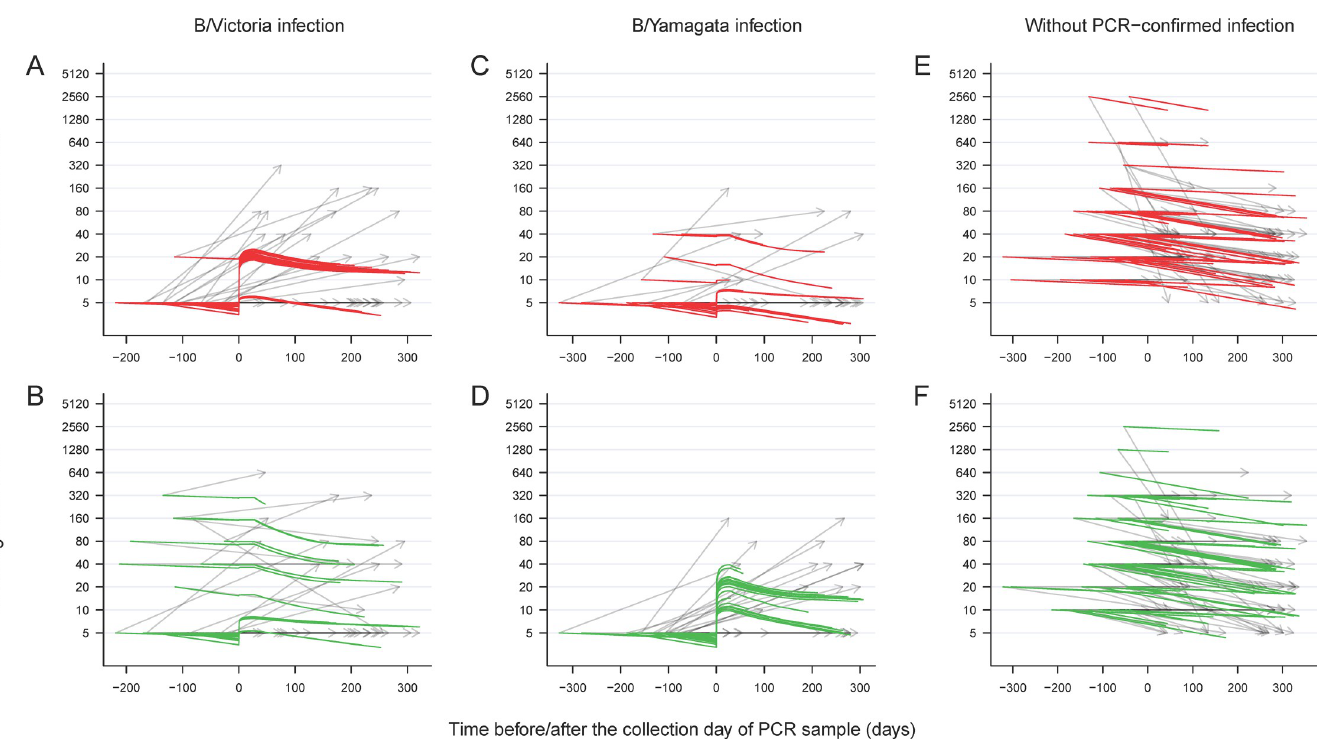
Fig 1. Modeled HAI antibody titer dynamics for the participants with and without PCR-confirmed infection in the overall analysis. Antibody titers measured by the hemagglutination inhibition (HAI) assay against B/Victoria and B/Yamagata lineage viruses (black lines) versus modeled HAI antibody titer dynamics (colored lines) for the PCR-confirmed cases and participants without PCR-confirmed infection from August 2009 to December 2014 included in the overall